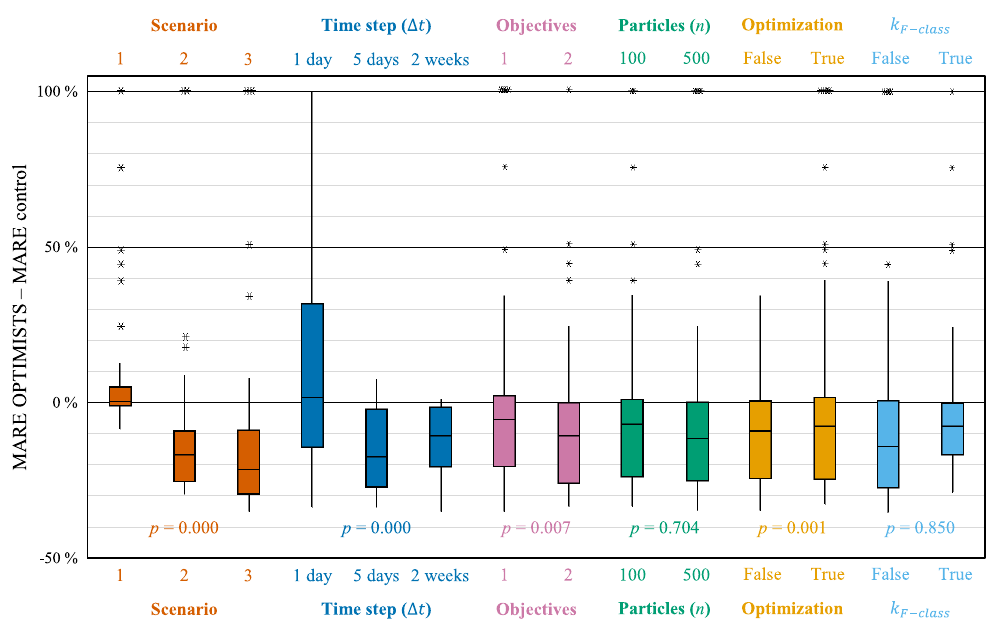
Figure 3. Box plots of the changes in forecasting error (MARE) achieved while using OPTIMISTS on Experiment 1 (Blue River). Changes are relative to an open-loop control run where no assimilation was performed. Each column corresponds to the distribution of the error changes on the specified scenario or assignment to the indicated parameter. Positive values indicate that OPTIMISTS increased the error, while negative values indicate it decreased the error. Outliers are noted as asterisks and values were limited to 100%. For the one-objective case, the particles’ MAE was to be minimized; for the two-objective case, the likelihood given the background was to be maximized in addition. No optimization (“false”) corresponds to p samp = 1 . 0 (i.e. all samples are obtained from the prior distribution); “true” corresponds to p samp = 0 . 25. The p values were determined using ANOVA (Montgomery, 2012) and indicate the probability that the differences in means corresponding to boxes of the same colour are produced by chance (e.g. values close to zero indicate certainty that the parameter effectively affects the forecast